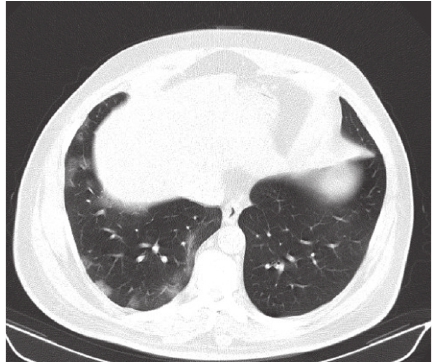
Figure 1: Spiral chest CT scan of the patient on day